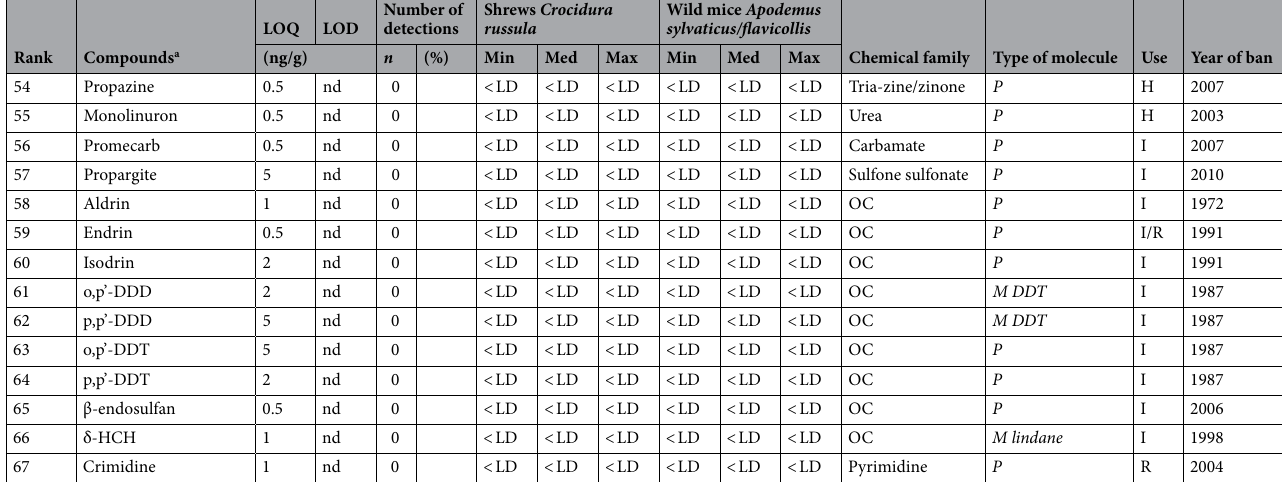
Table 1. Concentrations of banned and restricted pesticides (BRPs) in small mammal hair samples, classified by decreasing number of detection. Maximum concentrations higher than 10 ng/g are in bold. The year of ban of BRPs is indicated for France when available, otherwise for European Union; note that effective use in the field might have ceased a few months/years before or after the vote of the regulation; the year is also indicated for specific metabolites as the year of ban of the parent compound. Abbreviations in headers: LOQ limit of quantification, LD Lowest detected value (nd, not detected), Min minimum, Med median, Max maximum. Abbreviations for chemical family and type of molecule: OP Organophosphorous, OC Organochlorine, P parent chemical, M metabolite. Abbreviations for type of use: B biocide, F fungicide, H herbicide, I insecticide, R rodenticide. *Also a metabolite of triazines. a List of